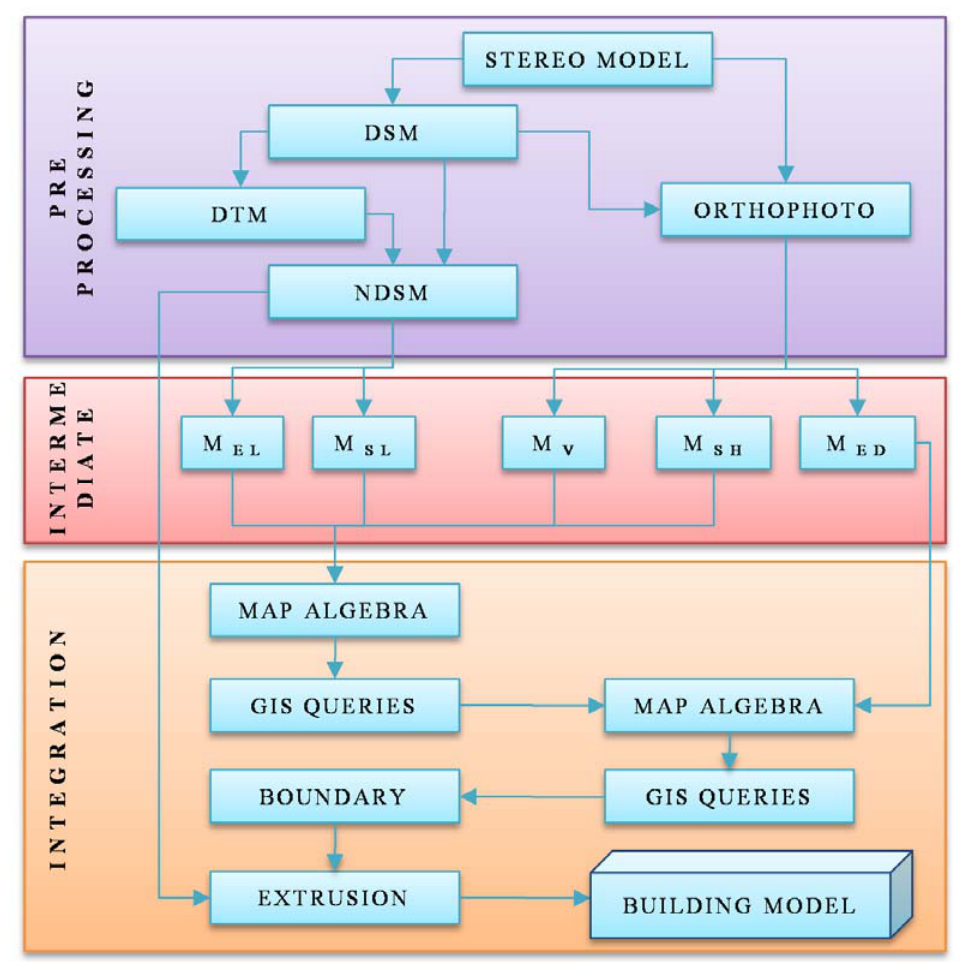
Figure 2. Building detection and extraction block